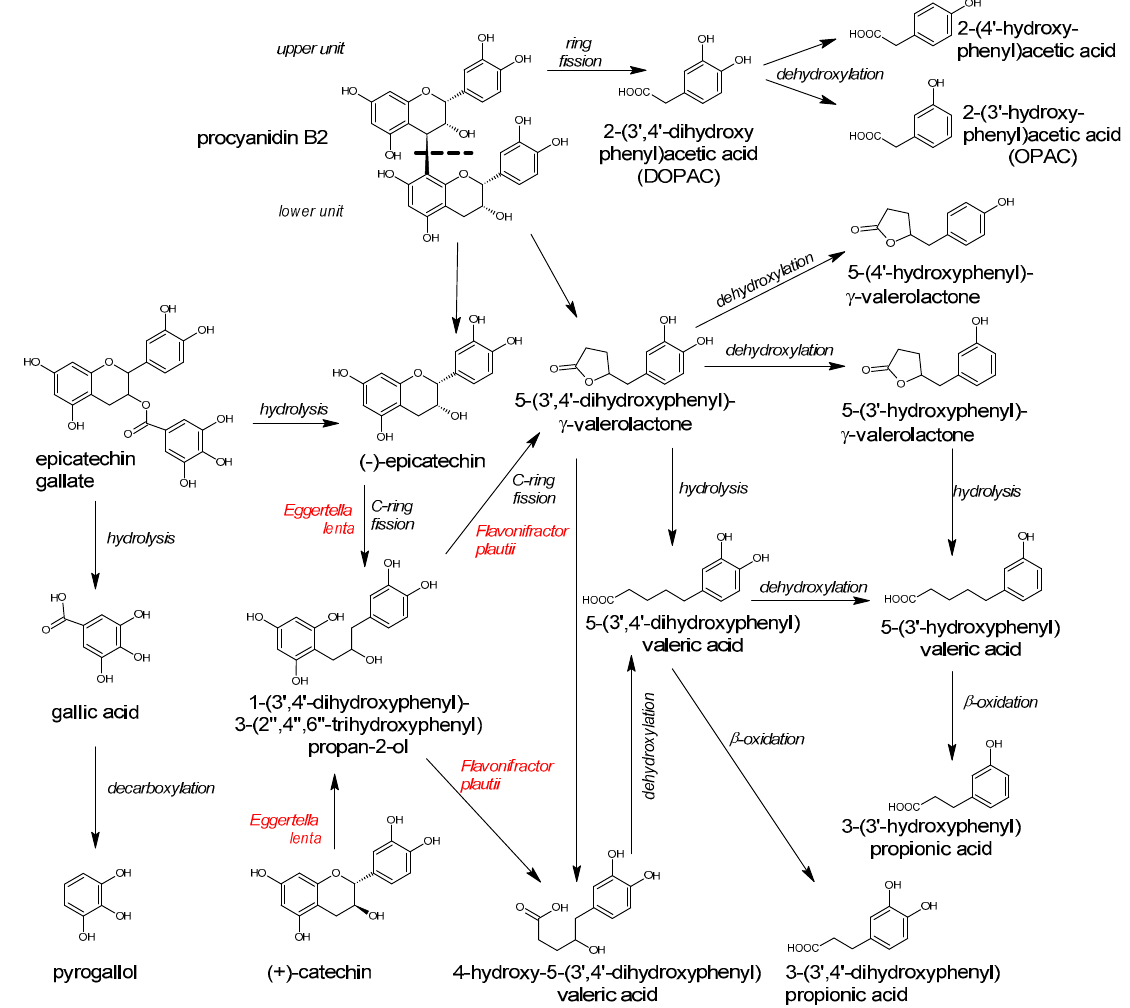
Figure 16. Microbial metabolism of procyanidin B2, ( − )-epicatechin and (+)-catechin. Based on [274,291,294–297]. The incubation of purified (+)-catechin, ( − )-epicatechin, procyanidins A2 and B2, as well as partially purified apple and cranberry procyanidins with human gut microbiota, resulted in their degradation. The common metabolites were benzoic acid, 2-phenylacetic acid, 3-phenylpropionic acid, 2-(3 ′ -hydroxyphenyl) acetic acid (OPAC), 2-(4 ′ -hydroxy- phenyl) acetic acid, 3-(3 ′ -hydroxyphenyl) propionic acid, and hydroxyphenylvaleric acid. Interesting, that 5-(3 ′ ,4 ′ -dihydroxyphenyl)- γ -valerolactone and 5-(3 ′ -hydroxyphenyl)- γ - valerolactone were identified as the bacterial metabolites of epicatechin, catechin, procy- anidin B2, and purified apple procyanidins, but not from the procyanidin A2 or cranberry procyanidin ferments, while 2-(3 ′ ,4 ′ -dihydroxyphenyl) acetic acid was only found in the fermented broth of procyanidin B2, A2, apple, and cranberry procyanidins [298]. The monomeric flavan-3-ols, which are usually shared by condensed tannins, can be degraded by fecal microbiota into low molecular weight aromatic compounds, including phenylpropionic acid, 2-(3 ′ -hydroxyphenyl) acetic acid, 3-(3 ′ -hydroxyphenyl) propionic acid, 5-(3 ′ -hydroxyphenyl) valeric acid, phenylacetic acid, and 2-(4 ′ -hydroxyphenyl) ace- tic acid [294]. Similar results have been obtained Appeldoorn et al. [296]. Purified procy- anidin dimers, when incubated with human microbiota, have been transformed and among major identified metabolites were 2-(3 ′ ,4 ′ -dihydroxyphenyl) acetic acid (DOPAC) and 5-(3 ′ ,4 ′ -dihydroxyphenyl)- γ -valerolactone. Other metabolites detected were: OPAC, 2-(4 ′ -hydroxyphenyl) acetic acid, 3-(3 ′ -hydroxyphenyl) propionic acid, phenylvaleric ac- ids, monohydroxylated phenylvalerolactone, and 1-(3 ′ ,4 ′ -dihydroxyphenyl)-3-(2 ′′ ,4 ′′ ,6 ′′ -